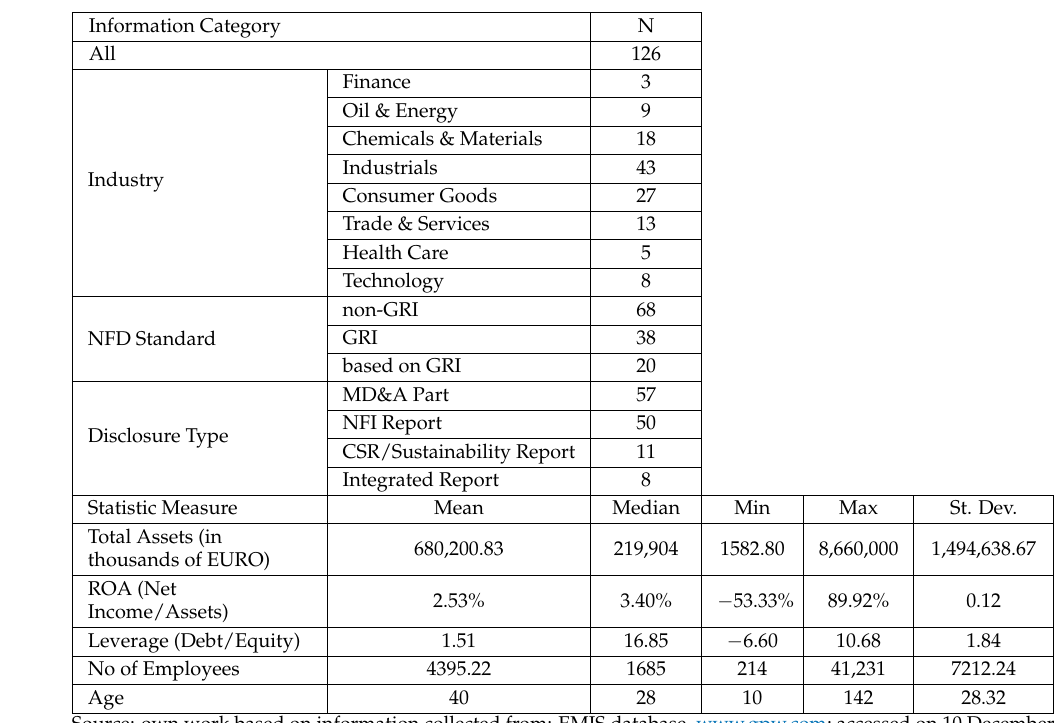
Table 1. Characteristics of the